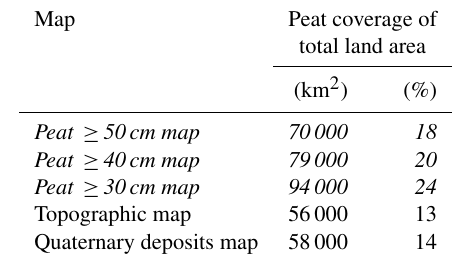
Table 2. Coverage of peatlands in Sweden according to different maps, in km 2 or in % of the land area in Sweden (excluding lakes and large ≥ 6m wide rivers). The peat maps that we predicted in this study are highlighted in italics. The topographic and Quaternary deposits maps are existing national